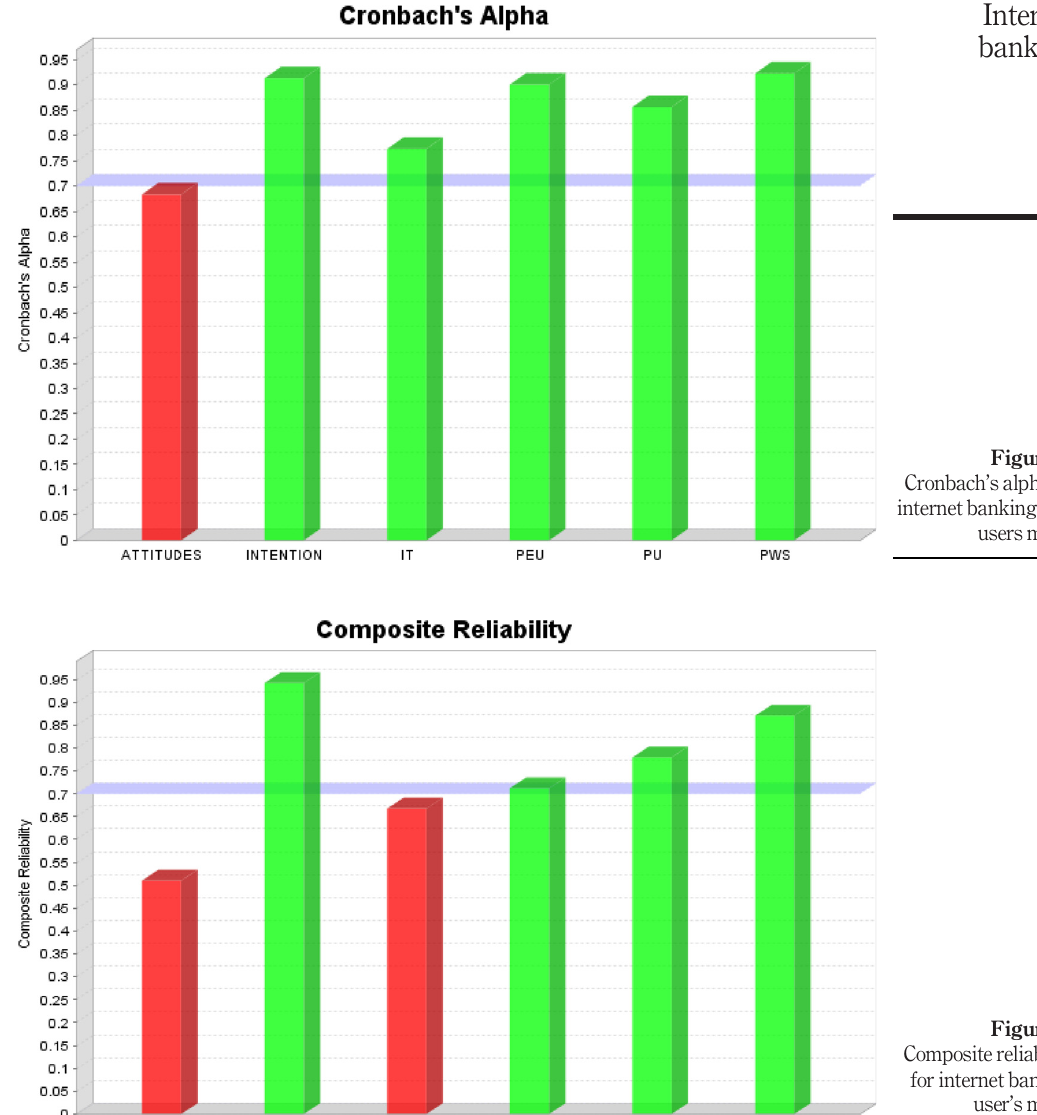
Figure 6. Composite reliability for internet banking user ’ s